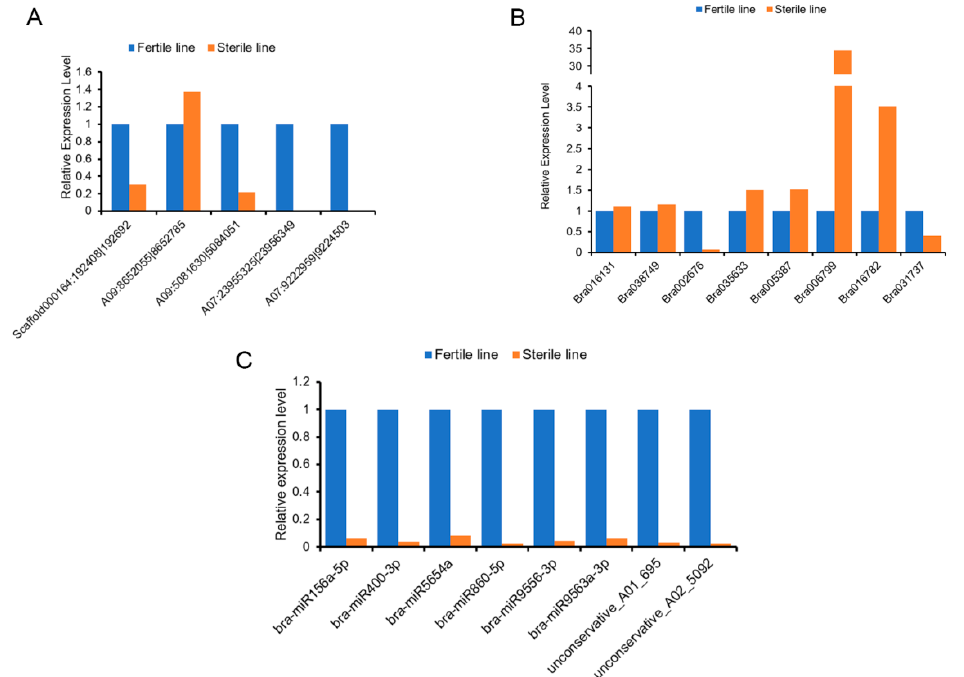
Figure 8. Quantitative real-time PCR validation for the RNA-seq data. ( A ) qRT-PCR validation of circRNAs. ( B ) qRT-PCR validation of mRNAs. ( C ) qRT-PCR validation of miRNAs.